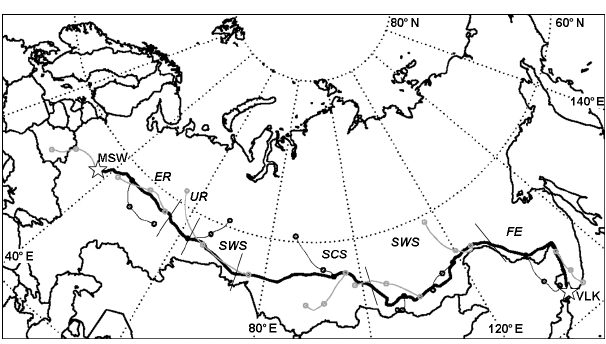
Figure 1. Schematic representation of the TROICA-12 route from Moscow (MSW) to Vladivostok (VLK). Thin solid lines across the route represent approximate boundaries of various geographic re- gions: European Russia (ER), Ural Mountains region (UR), south- ern parts of west (SWS), central (SCS), and east (SES) Siberia, and the Far East region (FE). Backward 2-day trajectories with end- points at Trans-Siberian Railway at local noon of each successive day of carriage movement are shown for east (black solid) and west (gray solid) routes of the campaign. Open circles mark air particle positions at 0, 24, and 48h along the each